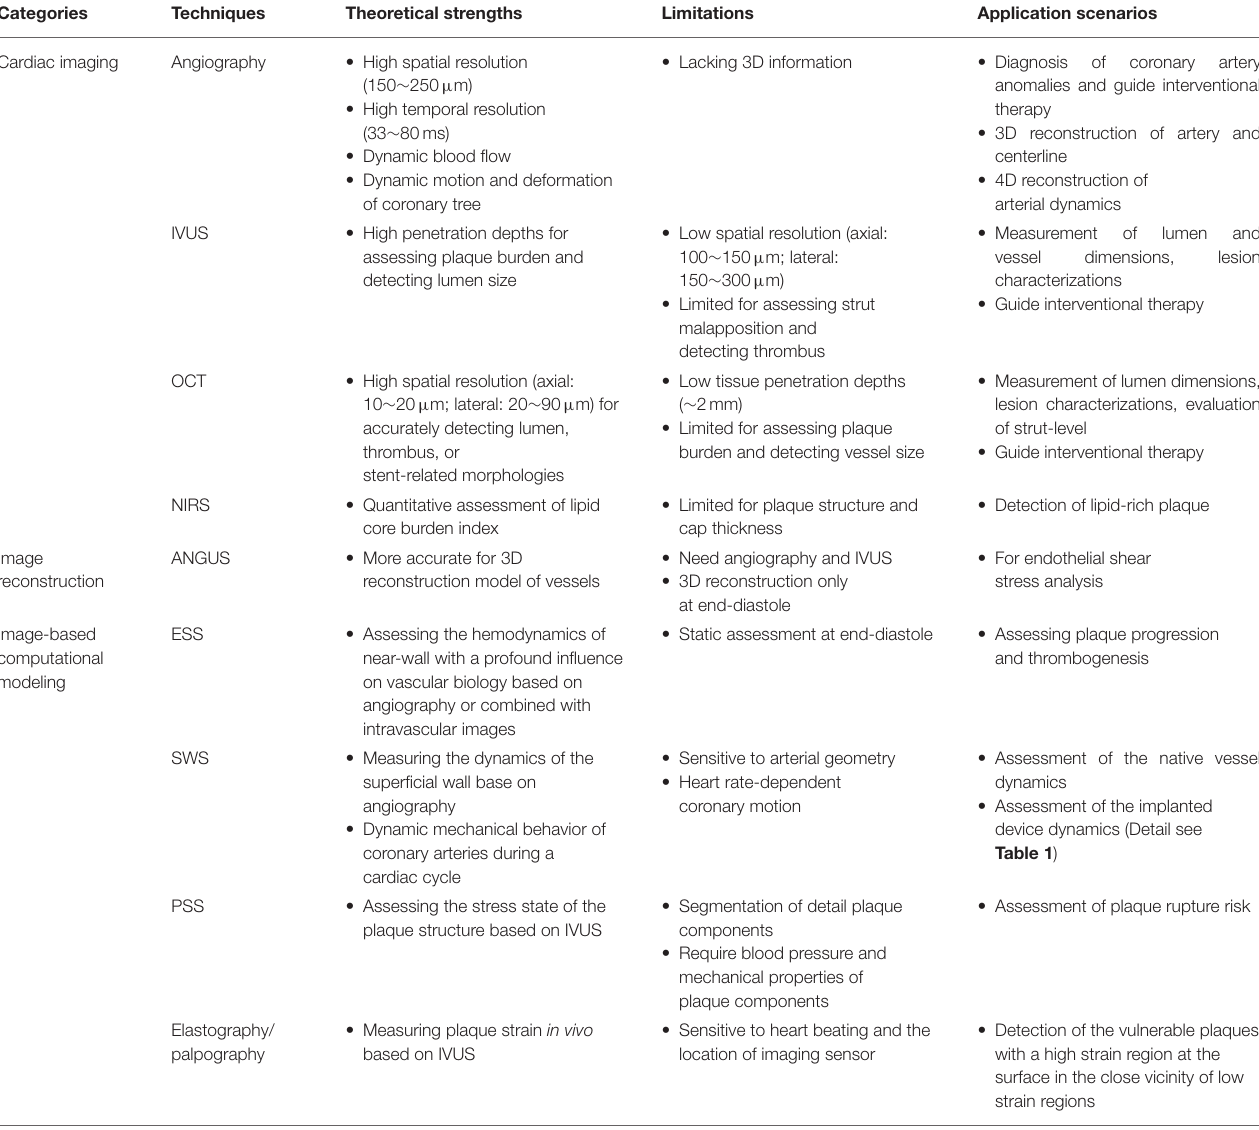
TABLE 2 | Summary of cardiac imaging and computational modeling